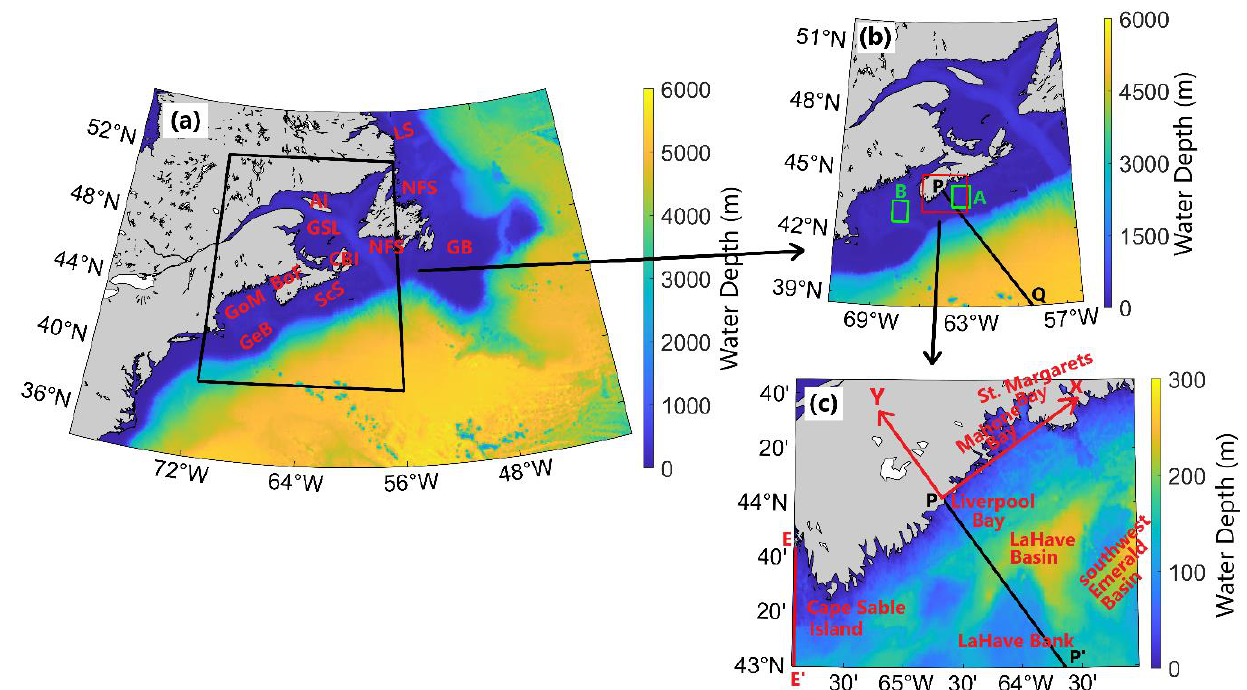
Figure 1. Major geographic features and domains of the three submodels composing the nested-grid coupled circulation-ice modelling system (NGMS-seCS) for the southeastern Canadian shelf and adjacent deep ocean waters of the northwest Atlantic Ocean. The horizontal resolutions of submodels ( a ) L1, ( b ) L2, and ( c ) L3 are 1/12 ◦ , 1/36 ◦ , and 1/108 ◦ , respectively. The color image in each subplot represents water depths. Transect PP’ is a cross-shelf transect originating from Liverpool Bay. Transect PQ is the extension of transect PP’ over the L2 domain. Transect EE’ is a north-south transect originating from Yarmouth, which is close to the western open boundary of submodel L3. Figure 1c shows the coordinate system for the transects PP’ and PQ. Definitions of abbreviations are given in Appendix A. Green boxes A and B are in the swScS and central GoM, respectively, over which the time series of simulated SST are compared with the satellite remote sensing observations.